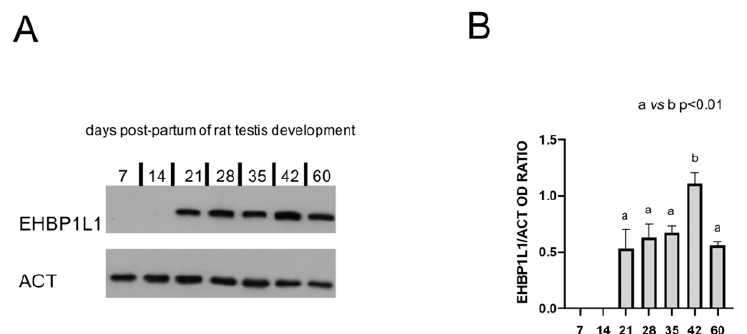
Figure 1. EHBP1L1 protein level during the first wave of rat spermatogenesis. ( A ): Western blot analysis showing the expression of EHBP1L1 (164 kDa, top section) and ACTIN (42 kDa, bottom section) during rat testis post-natal development at 7, 14, 21, 28, 35, 42, and 60 days postpartum (dpp). ( B ): Histogram showing the relative expression levels of EHBP1L1 in all the analyzed samples. Data were normalized with ACTIN and reported as EHBP1L1/ACT OD ratio. All data represent the mean ± SEM. a vs. b: p < 0.01. Western blot experiment was performed in triplicate.